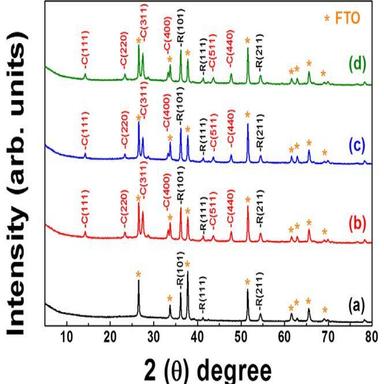
XRD patterns of (a) bare TONR/FTO, (b) (×3)-CdIS/TONR/FTO, (c) (×4)-CdIS/TONR/FTO, and (d) (×5)-CdIS/TONR/FTO.